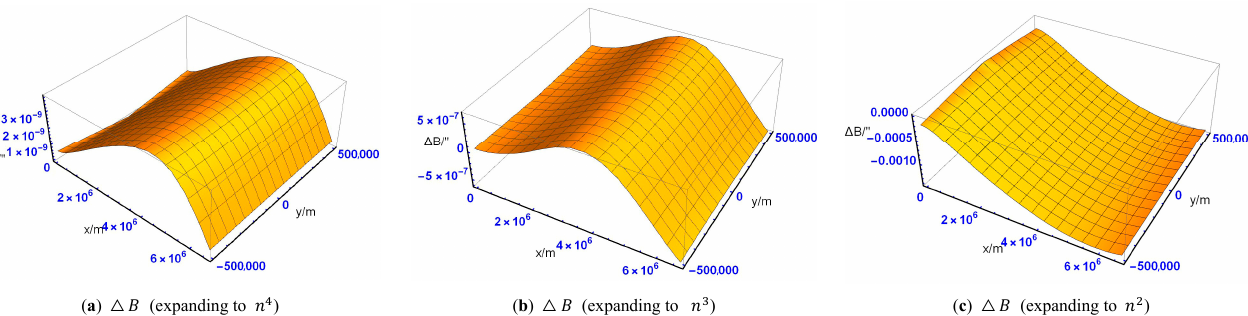
Figure 10. The distribution of the latitude truncation difference ∆ B when expanding to n 4 , n 3 , and n 2 .